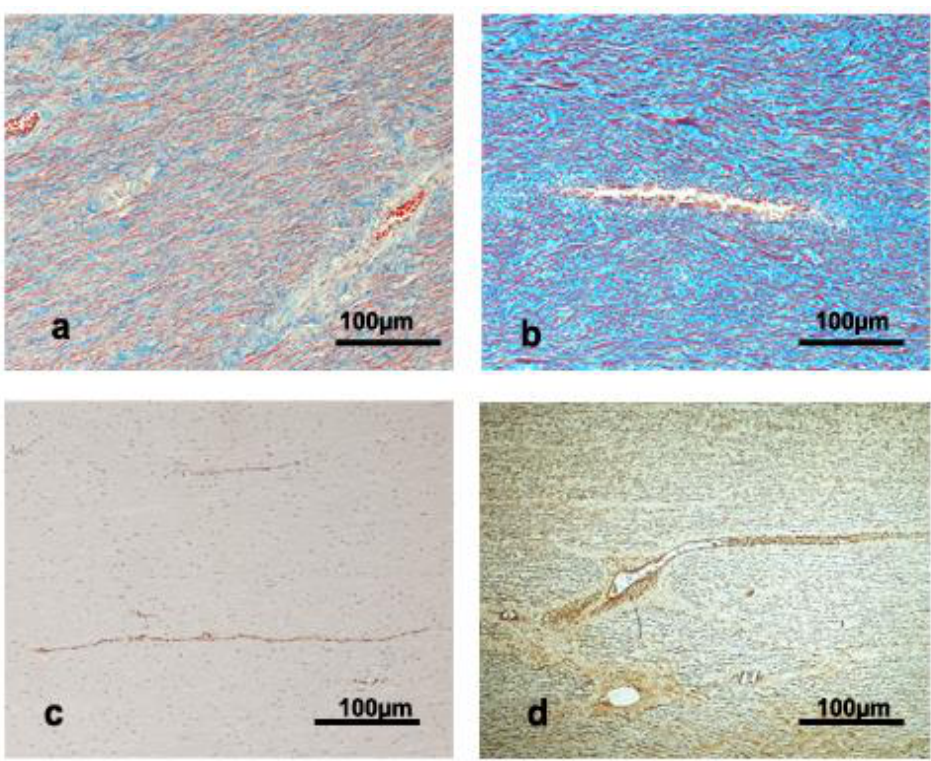
Figure 2. Large blood vessels inside the tunica media, ( a ) thoracic aorta in a calf female Physeter macrocephalus (trichromic stain), ( b ) ascending aorta in a subadult male Physeter macrocephalus (trichromic stain), ( c ) thoracic aorta in a subadult male Physeter macrocephalus (von Willebrand factor immune detection), ( d ) thoracic aorta in a Mesoplodon bidens adult female (alfa-actin immunodetection). The number of lamellar units ranged from 571 for Physeteridae to 102.4 ± 52.6 for Kogiidae (Table 3). The tunica adventitia was composed of diffuse connective tissue, mi- cro-vessels, and nerves.